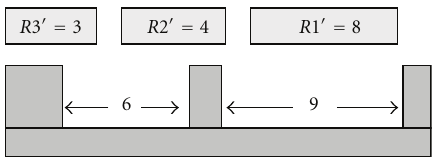
Figure 3: The state of holes and requests after prescaling